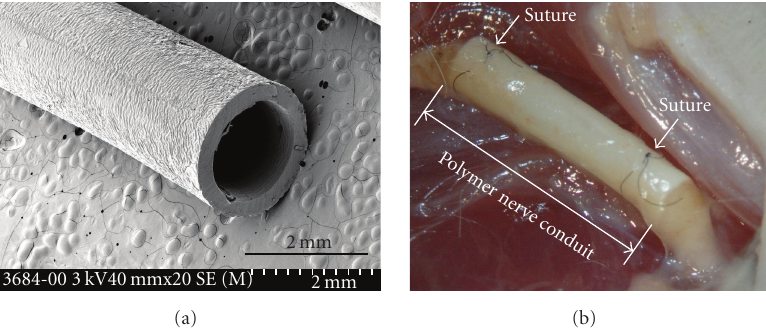
Figure 1: Polymer nerve conduits made from crosslinked poly ( ε -caprolactone) fumarate (PCLF) before (a) and after (b) implantation in the rat sciatic nerve. (Source: [83], copyright with permission from Elsevier